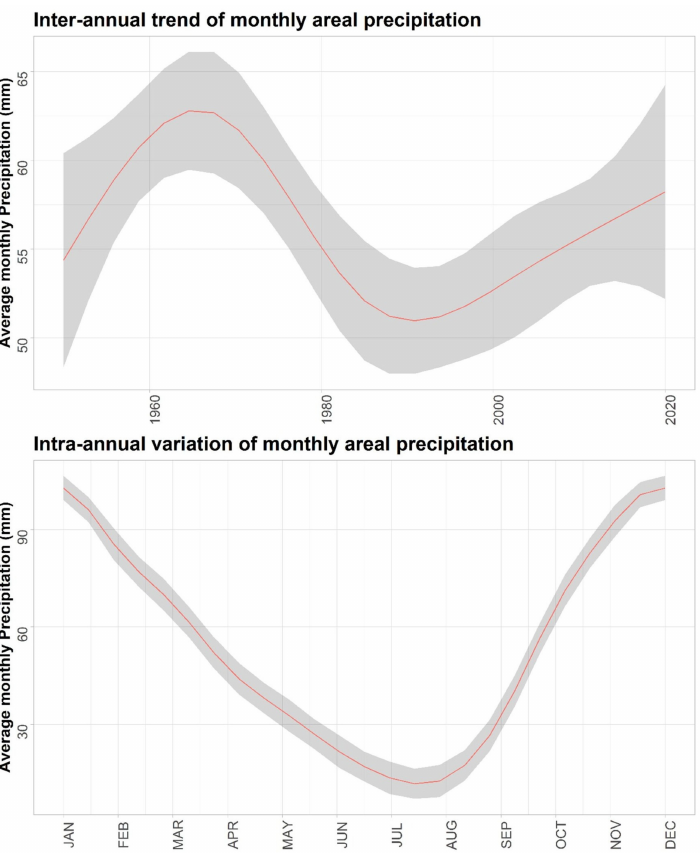
Figure 10. Fitted GAM inter-annual trend and intra-annual variation to monthly areal precipitation (mm) over the study area. The shaded area represents the 95% confidence intervals.